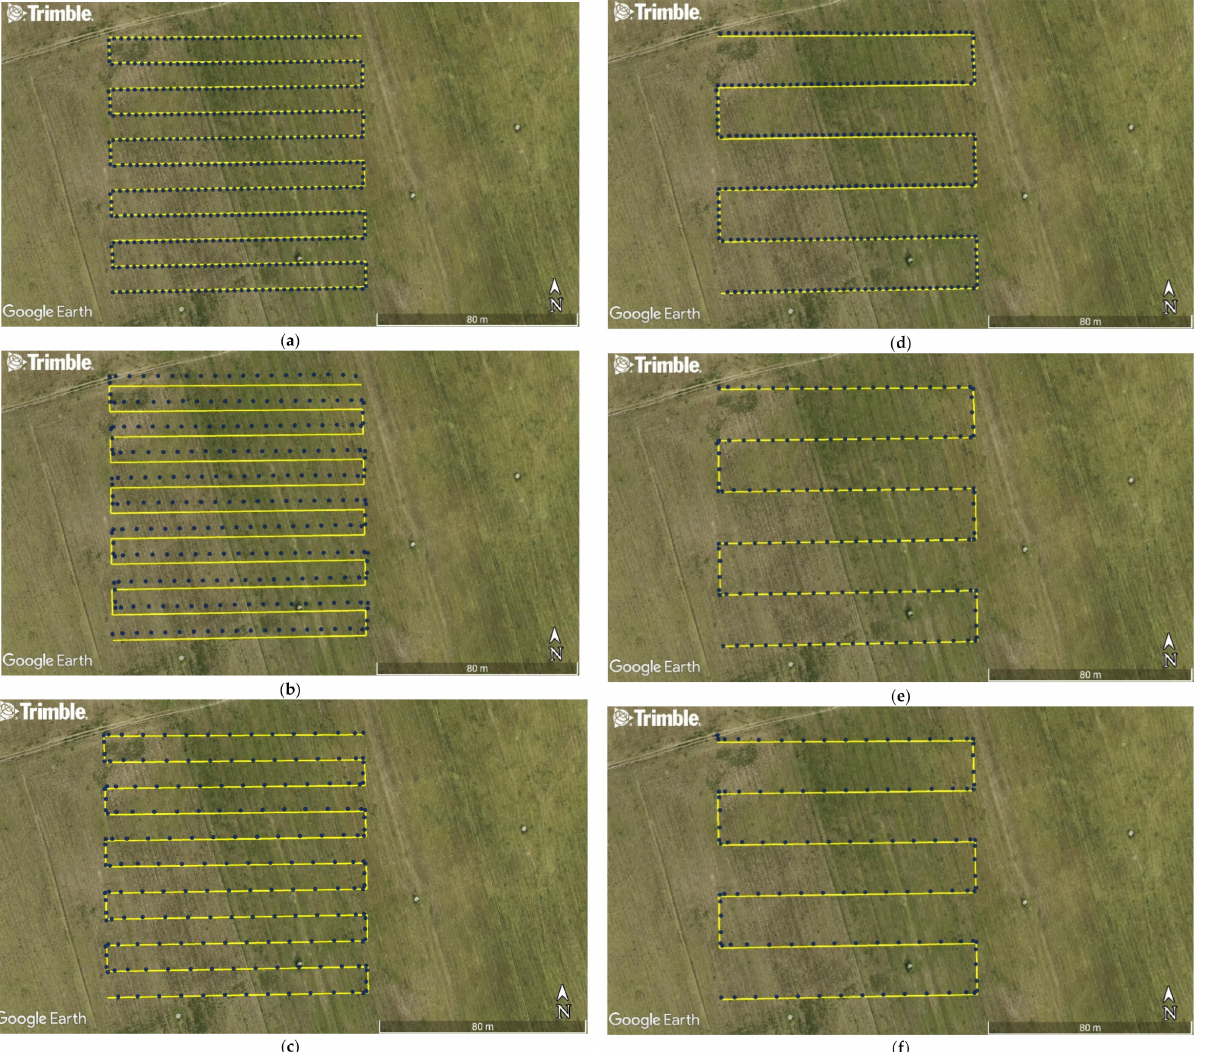
Figure 2. The points recorded by a GNSS RTK receiver (navy blue colour) along the routes comprised of parallel profiles distant from each other by: 10 m at a speed of 10 km/h ( a ), 20 km/h ( b ) and 30 km/h ( c ), as well as 20 m at a speed of 10 km/h ( d ), 20 km/h ( e ) and 30 km/h ( f